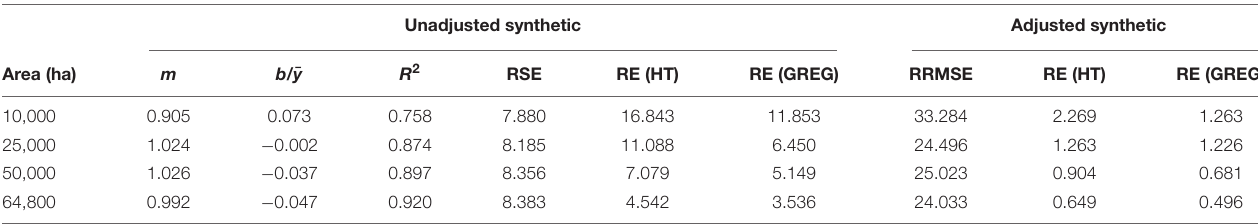
TABLE 2 | Regression results ( y = mx + b ) of the scatterplot of the unadjusted synthetic ( x ) vs. HT ( y ) estimates across spatial scales, along with median relative standard error (% of estimate) and median relative efficiency of the synthetic vs. HT and GREG estimators. Unadjusted